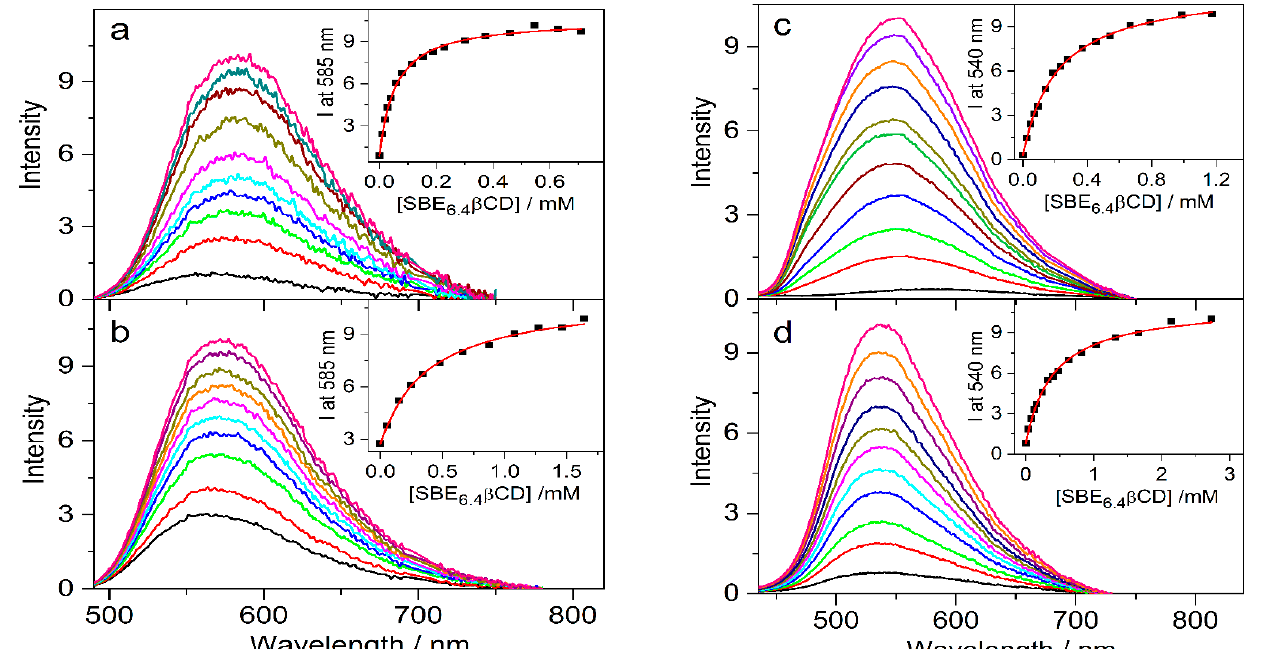
Figure 8. Fluorescence spectra of ( a ) 4.4 μ M C, ( b ) 4.3 μ M E, ( c ) 4.2 μ M P, and ( d ) 4.6 μ M DHC in water and in the presence of various amounts of SBE 6.4 β CD. Insets display the SBE 6.4 β CD concentration dependence on the fluorescence intensity ( ▪ ) and the lines present the fitted function.